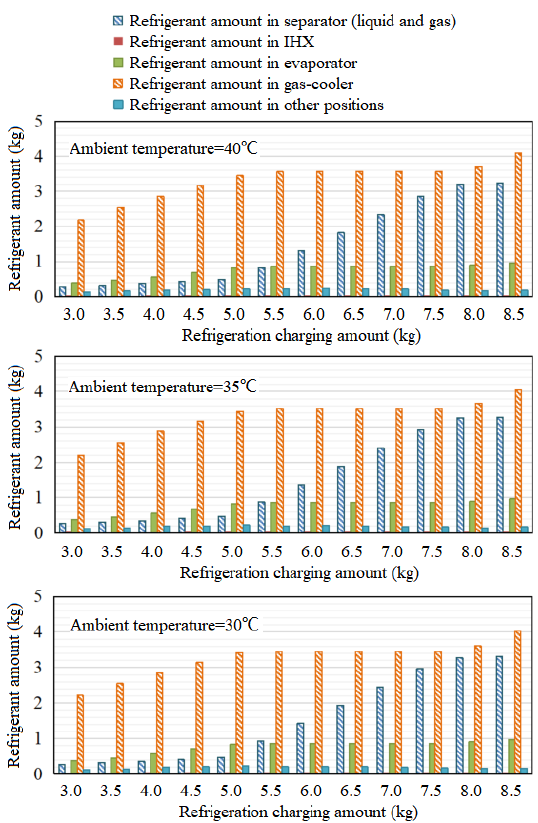
Figure 10. Refrigerant distribution versus refrigerant charging amount at different ambient temper- atures.